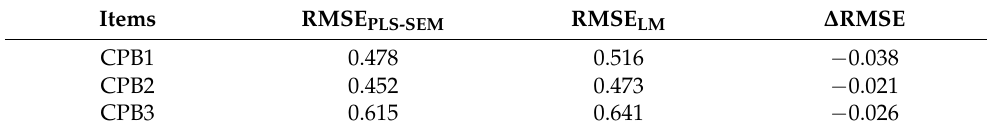
Table 6. PLS predicted assessment of the manifest variable consumer purchase behavior.